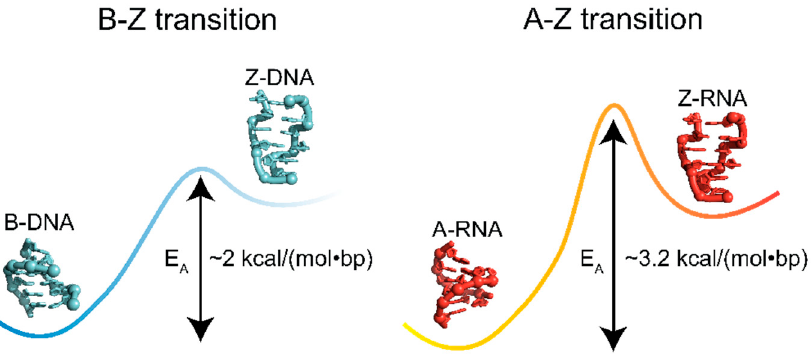
Figure 12. The B-to-Z transition is lower in energy compared to the A-to-Z transition. The activation energy for the transition from B-DNA (PDB: 1N1K [24]) to Z-DNA (PDB: 1QBJ [7]) is ~1.2 kcal/(mol·bp) lower than the transition from A-RNA (PDB: 1PBM [25]) to Z-RNA (PDB: 2GXB [10]).